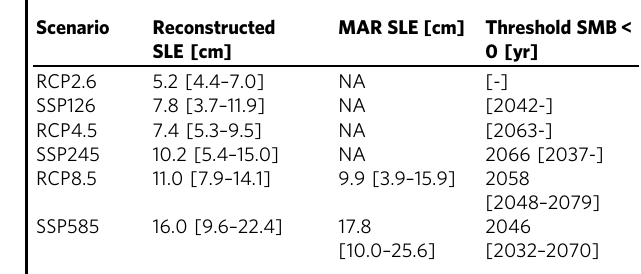
Table 1 Overview of the twenty- fi rst century Greenland